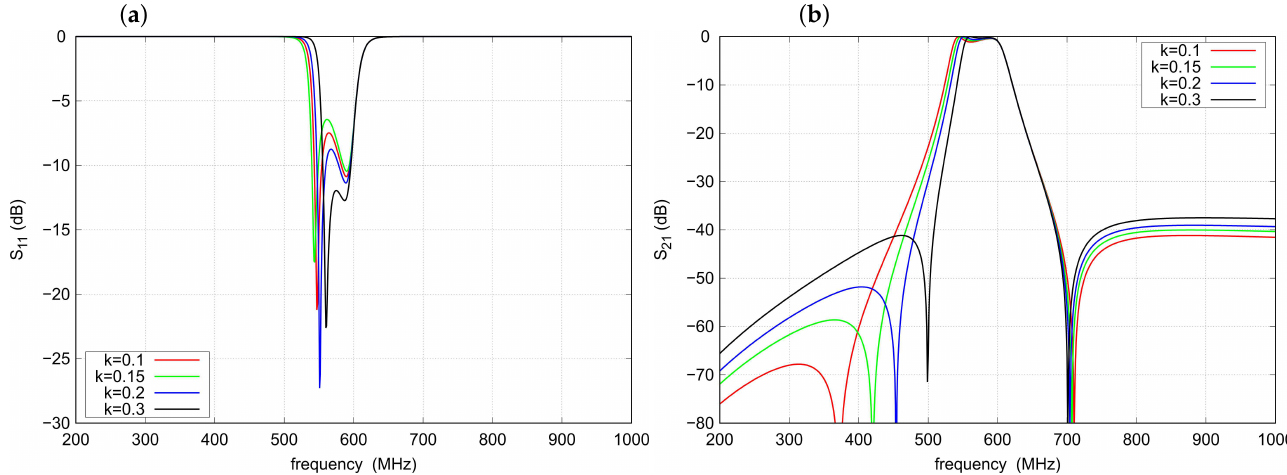
Figure 5. Effect of the division coefficient k on the filter response: ( a ) s 11 parameter, ( b ) s 21 parameter.